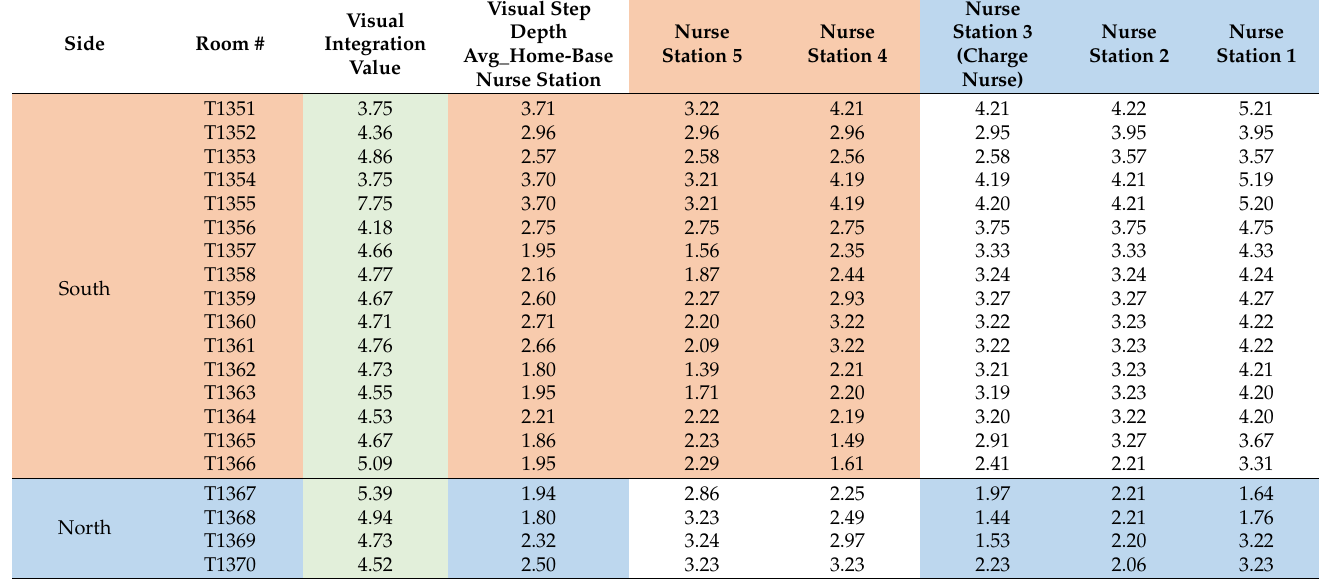
Table A1. Visual integration and visual step depth for each room in relation to each nurse station and home-base stations.